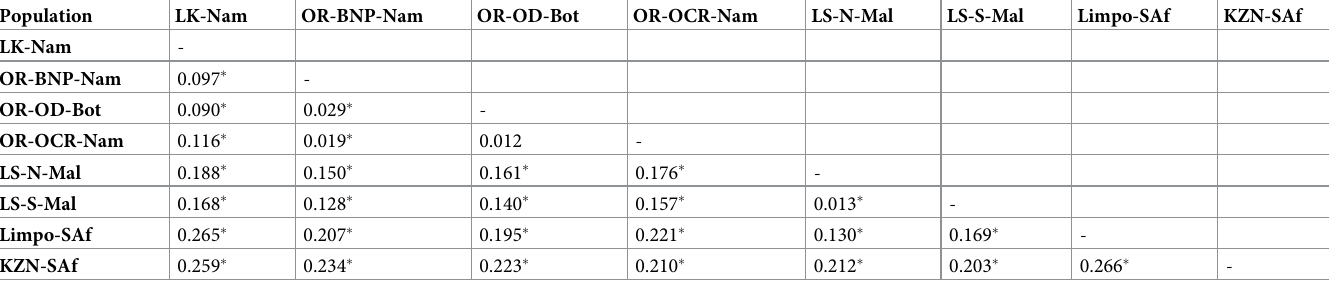
Table 2. Genetic divergence amongst Nile crocodile populations in southern Africa: Lower Kunene River (LK-Nam), Okavango River System (Okavango Delta— OR-OD-Bot and Okavango River—OR-OCR-Nam), North and South Lower Shire River (LS-N-Mal and LS-S-Mal), and South Africa’s Limpopo (Limpo-SAf) and KwaZulu-Natal (KZN-SAf) regions. Pairwise F ST values calculated using microsatellite genotypes are represented below the diagonal line.